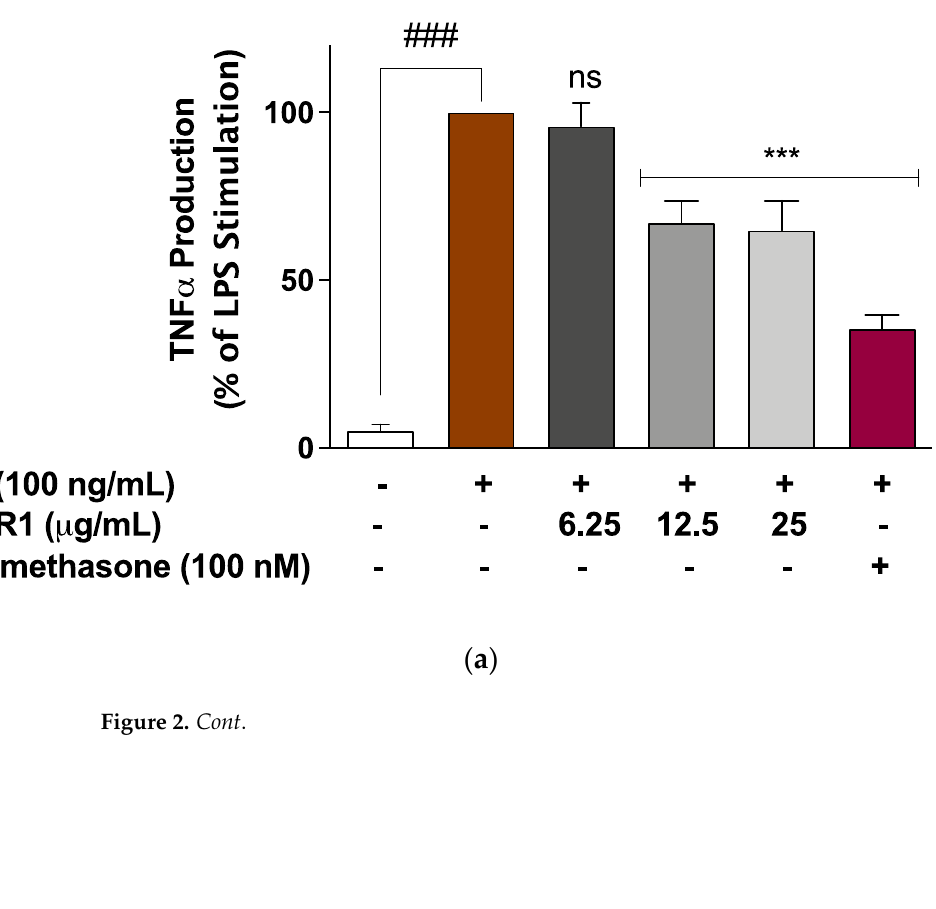
Figure 1. Pre-treatment with idoBR1 (12.5 and 25 µ g/mL) and dexamethasone (100 nM) reduced nitrite production in BV-2 microglia stimulated with LPS (100 ng/mL) for 24 h. Nitrite production was determined in culture supernatants obtained from BV2 microglia using Griess assay. All values are expressed as mean ± SEM for three independent experiments. Data were analyzed using one-way ANOVA for multiple comparisons with post hoc Student Newman–Keuls test. ns (not significant); ** p < 0.01; *** p < 0.001 (treatment vs. LPS stimulation only); ### p < 0.001 (unstimulated cells vs. stimulated with LPS only).